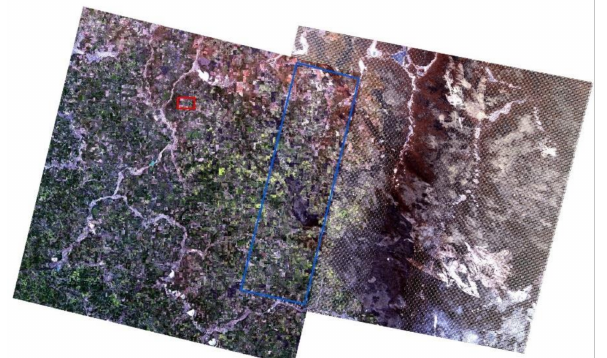
Figure 3. Overlap region (marked in blue) used to calibrate Landsat-8 NDVI to Landsat-7 NDVI values overlaid on false-colour composites of red, green and blue bands from the Landsat-8 OLI image acquired 2016-09-21 (left scene) and Landsat-7 ETM+ image acquired 2016-09-22 (right scene). The study area is marked in